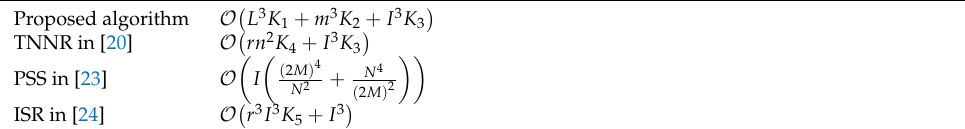
Table 2. Computation complexity comparison of different algorithms.